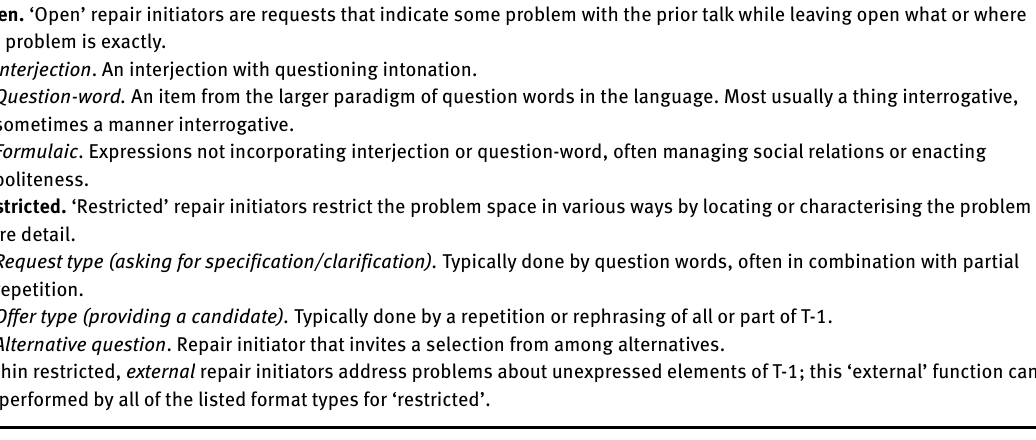
Table 2: Basic types of formats for other-initiation of